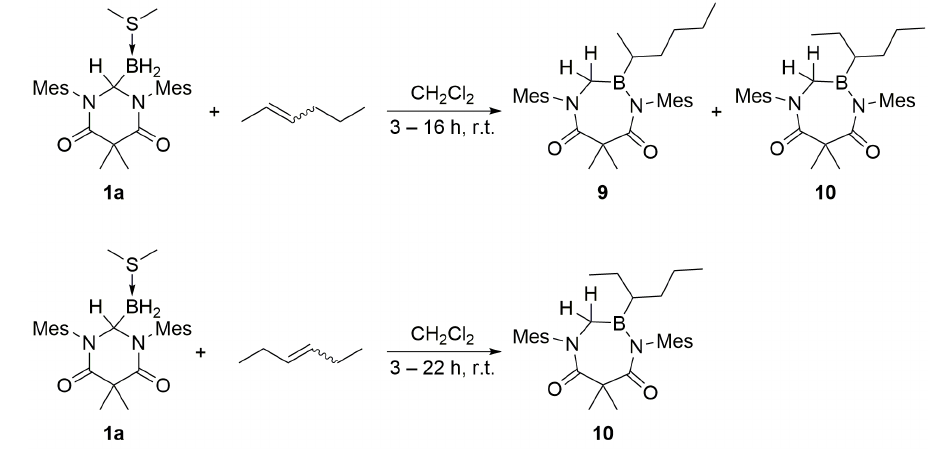
Scheme 7. Hydroboration of internal acyclic olefins with 1a .